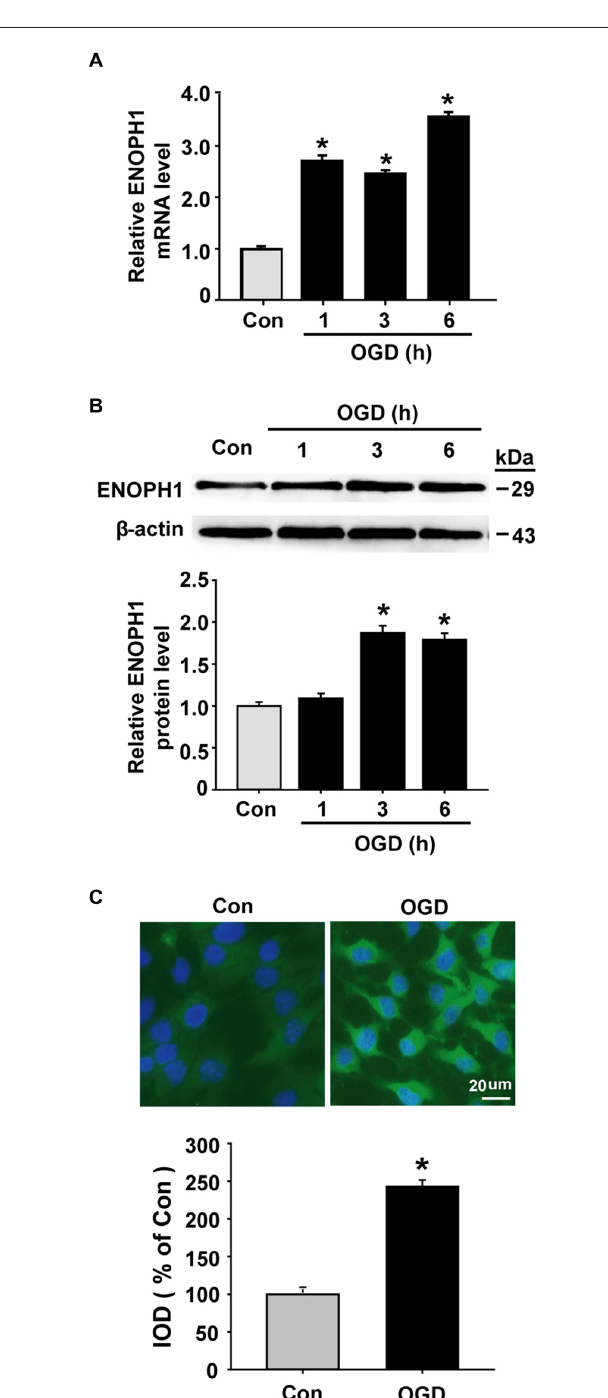
FIGURE 2 | Oxygen-glucose deprivation (OGD) induces upregulation of ENOPH1 in brain microvascular endothelial cells (bEND3 cells). bEND3 cells were subjected to OGD treatment or normoxia (Control, Con) for 1, 3, or 6 h before analyzing ENOPH1 mRNA and protein expression using real-time RT-PCR, western blot and immunostaining. (A) Real time RT-PCR analysis showed that ENOPH1 mRNA expression was significantly increased in bEND3 cells at 1 h after OGD treatment and was further increased when OGD was prolonged to 6 h. ∗ P < 0.05 vs. Con; n = 4. (B) Western blot